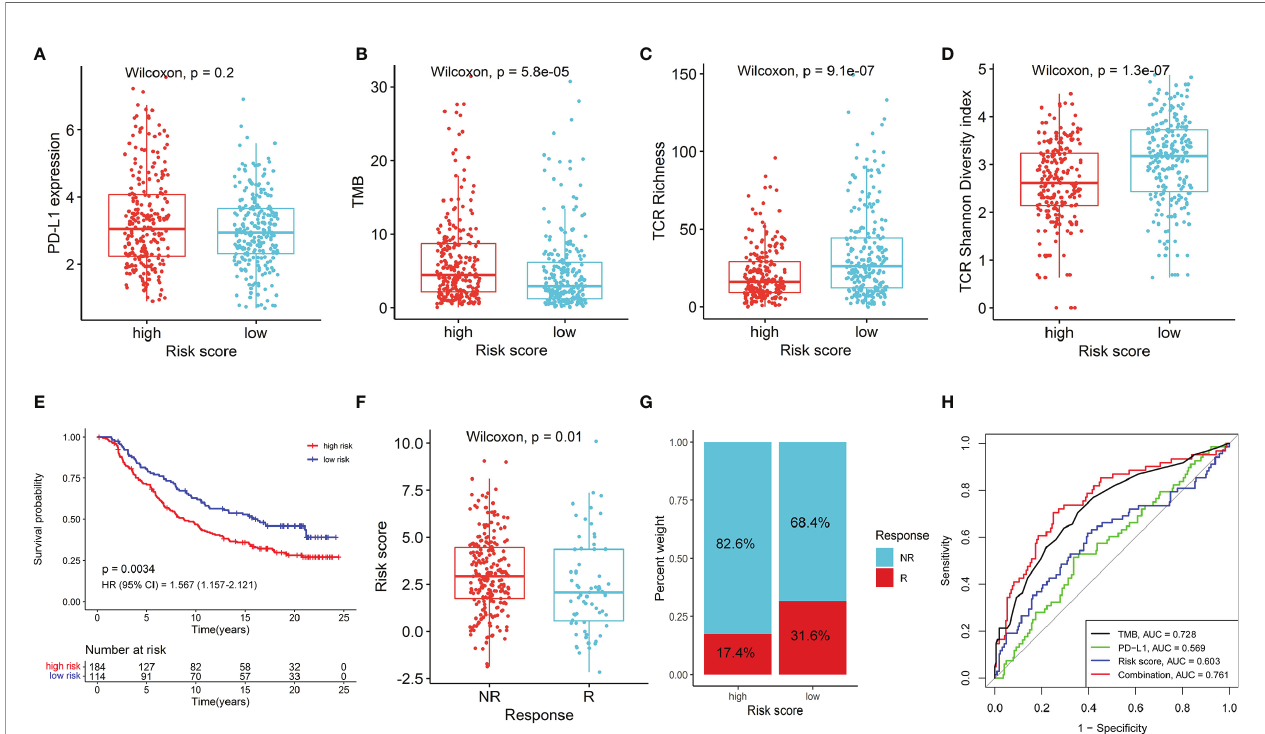
FIGURE 5 | The role of NKCMGS in predicting immunotherapeutic bene fi t. The comparison of PD-L1 expression (A) , tumor mutation burden (TMB) (B) , TCR richness (C) , TCR diversity (D) between high-risk and the low-risk patients. (E) Kaplan – Meier curves for patients with high-risk and low-risk scores in the IMvigor210 cohort. (F) The comparison of risk scores in groups with different anti-PD-L1 treatment response status in the IMvigor210 cohort. NR represents progressive disease (PD)/stable disease (SD); R represents complete response (CR)/partial response (PR). (G) Treatment response rates of anti-PD-L1 immunotherapy in high- and low-risk groups in the IMvigor210 cohort ( P = 0.005). NR represents SD/PD; R represents CR/PR. (H) ROC curves evaluating the predictive accuracy of the TMB, PD-L1, risk score, and combination of TMB, PD-L1, and risk score in the IMvigor210